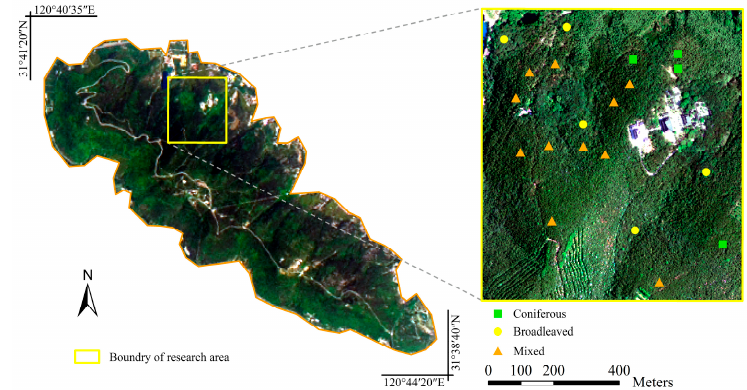
Figure 2. The location of study area in Yushan forest and the distribution of the plots of three main forest types: Coniferous dominated forest, broadleaved dominated forest and mixed forest. Left side is the orthophoto of Yushan forest and right side is the distribution of three types of plots.